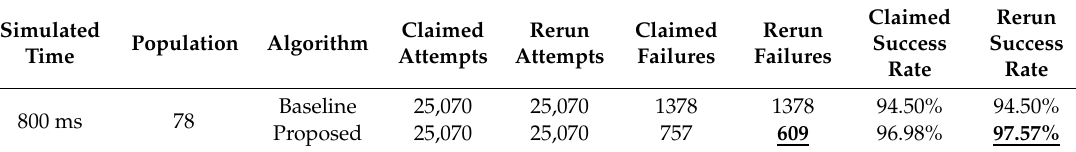
Table 10. Inconsistencies in results.